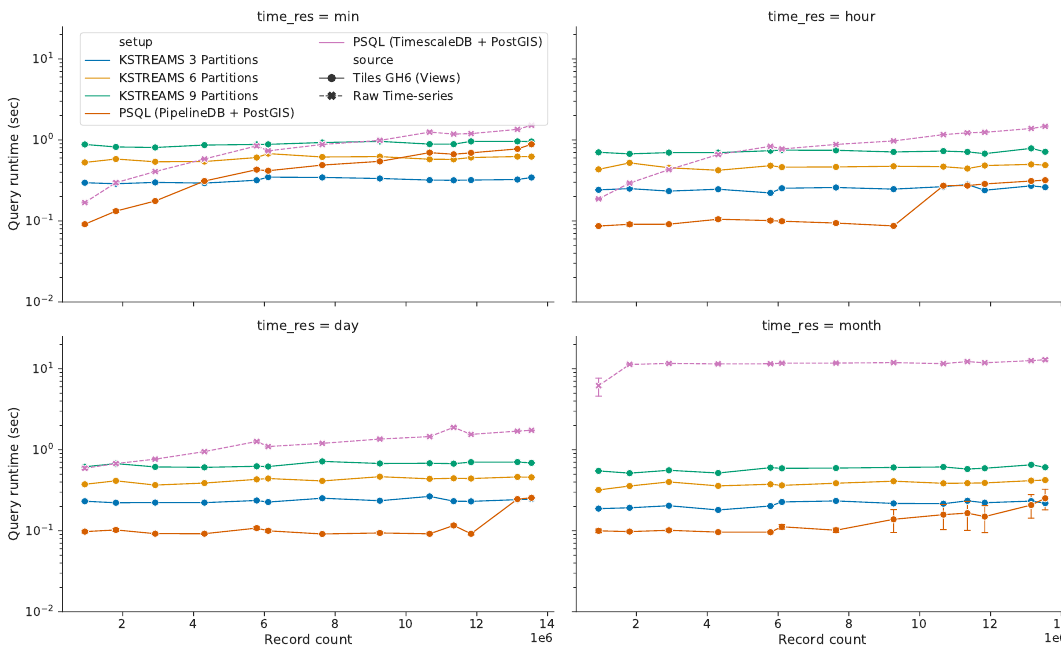
Figure 16. Query response time vs. volume of ingested data: ST